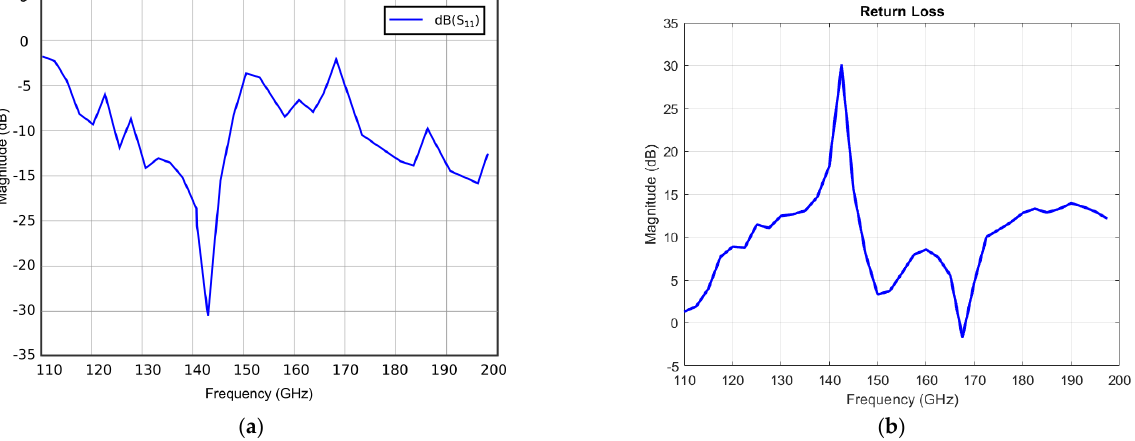
Figure 16. Minkowski fractal antenna for 2 iterations: ( a ) Self-reflection coefficient S 11 , ( b ) Return loss.